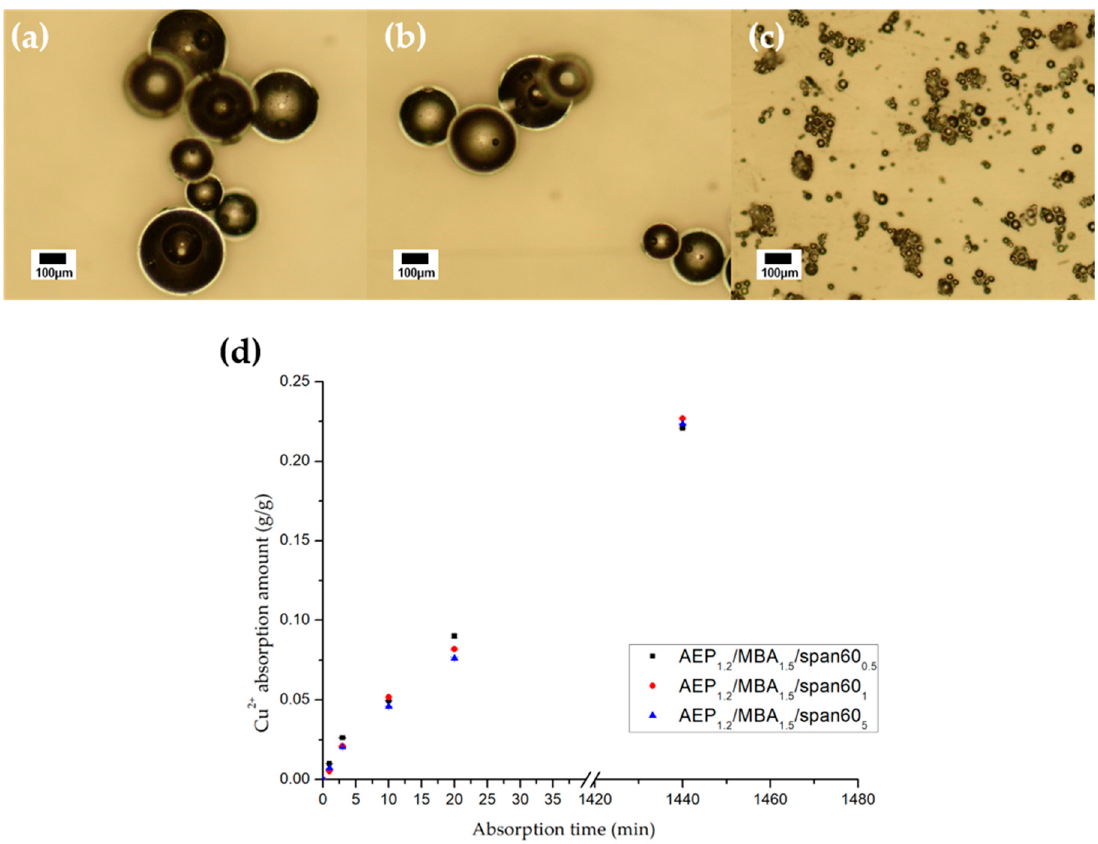
Figure 3. Size change of the hPAMAM particles with di ff erent span60 concentration. OM images of AEP 1.2 / MBA 1.5 / span60 0.5 ( a ), AEP 1.2 / MBA 1.5 / span60 1 ( b ), AEP 1.2 / MBA 1.5 / span60 5 ( c ), graph of copper (II) ion absorption amount at 1, 3, 10, 20 min, and 24 h in the three surfactant concentrations ( d